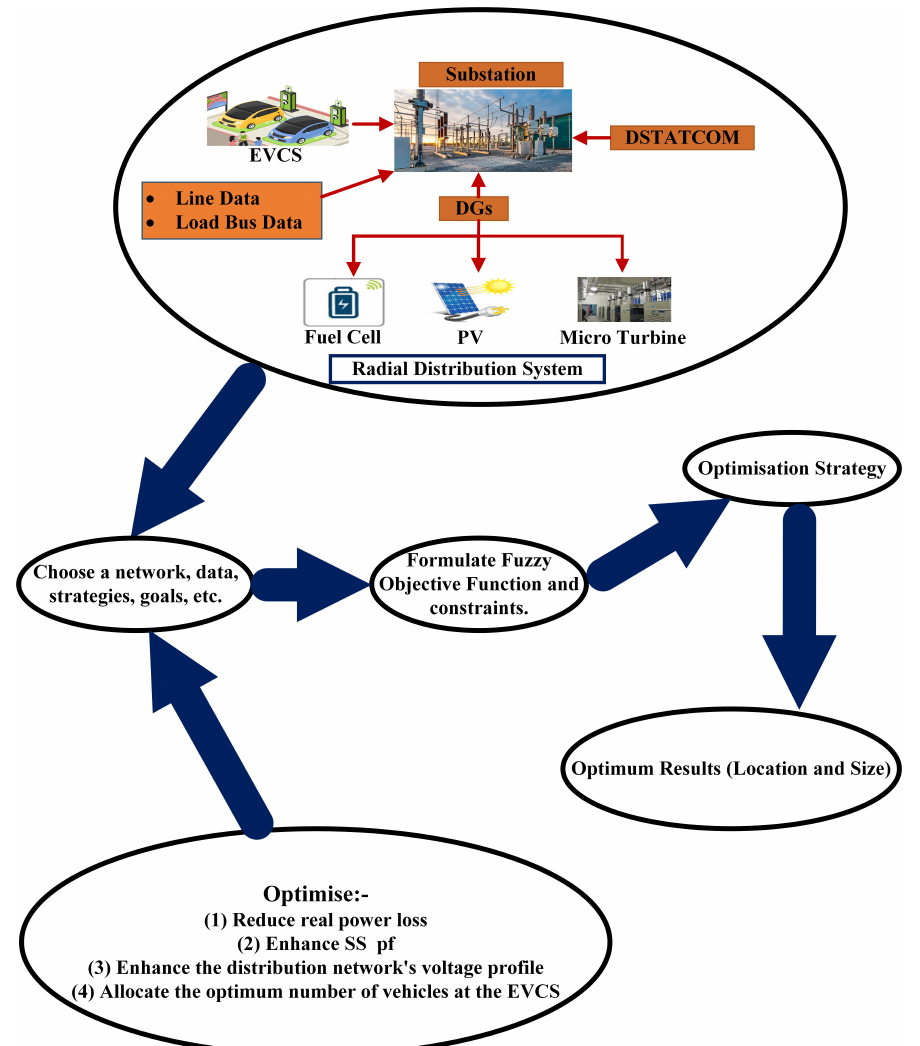
Figure 1. Synergistic planning framework of EVCS, DG, and DSTATCOM in the distribution